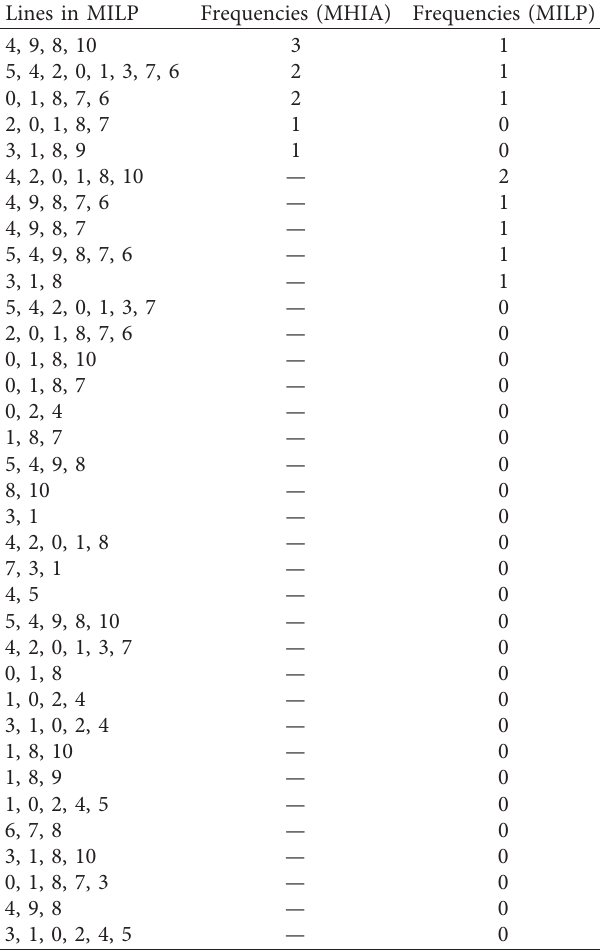
Table 11: Results for the given line pool for MHIA and MILP on the small HSR network.